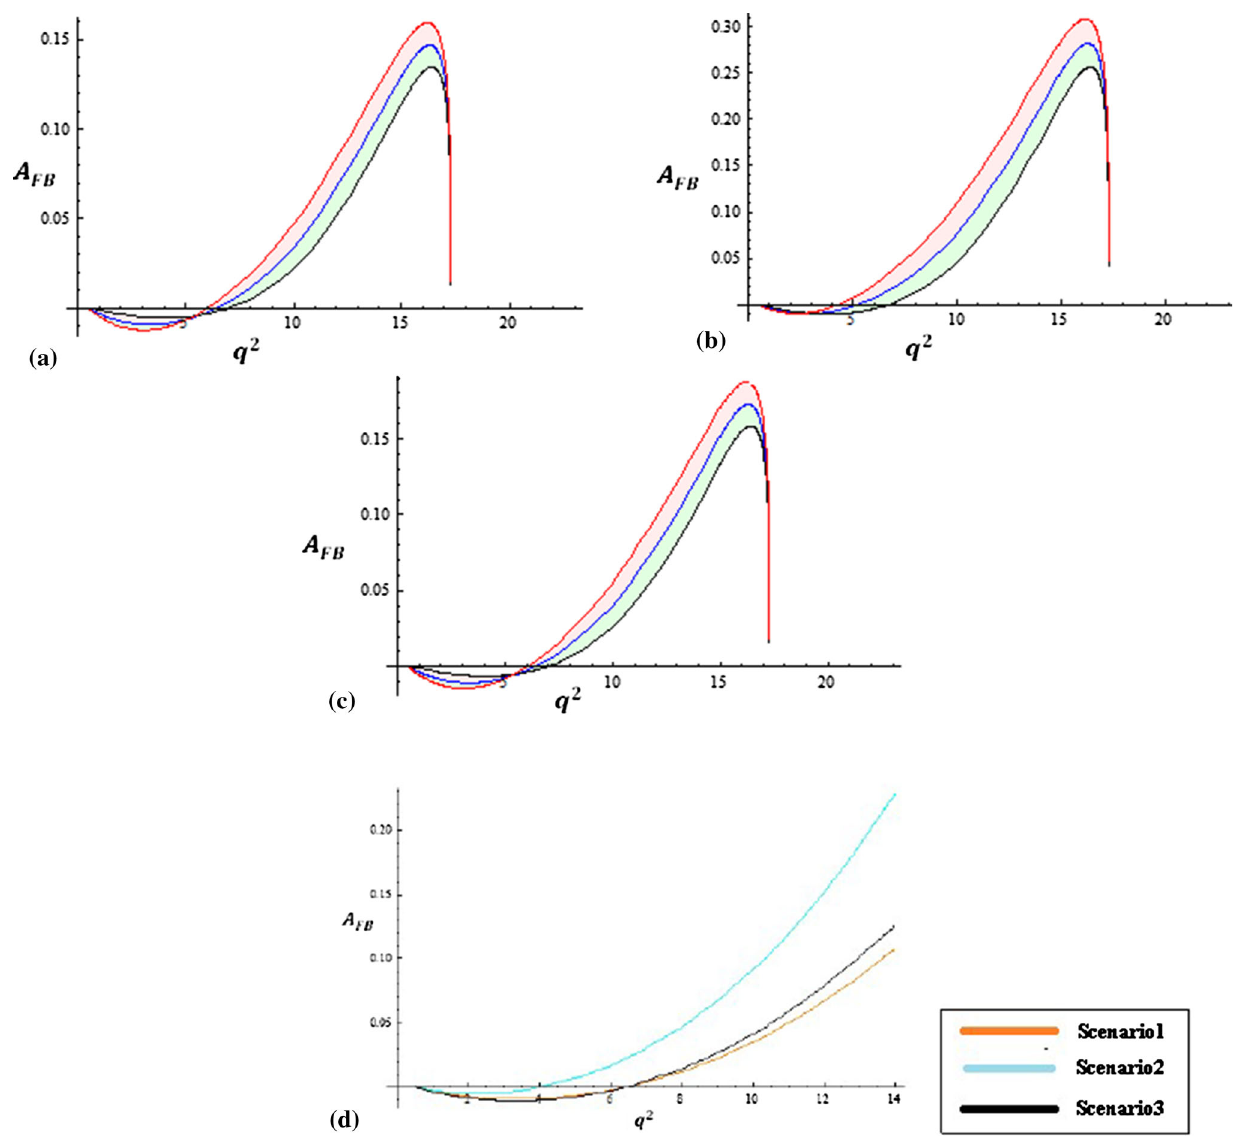
Fig. 6 Variation of lepton side forward backward asymmetry for (cid:2) → (cid:2)τ + μ − within allowed kinematic region of q 2 using the bound b ofNP couplings for a scenario1, b scenario2and c scenario3. 6d:Vari-